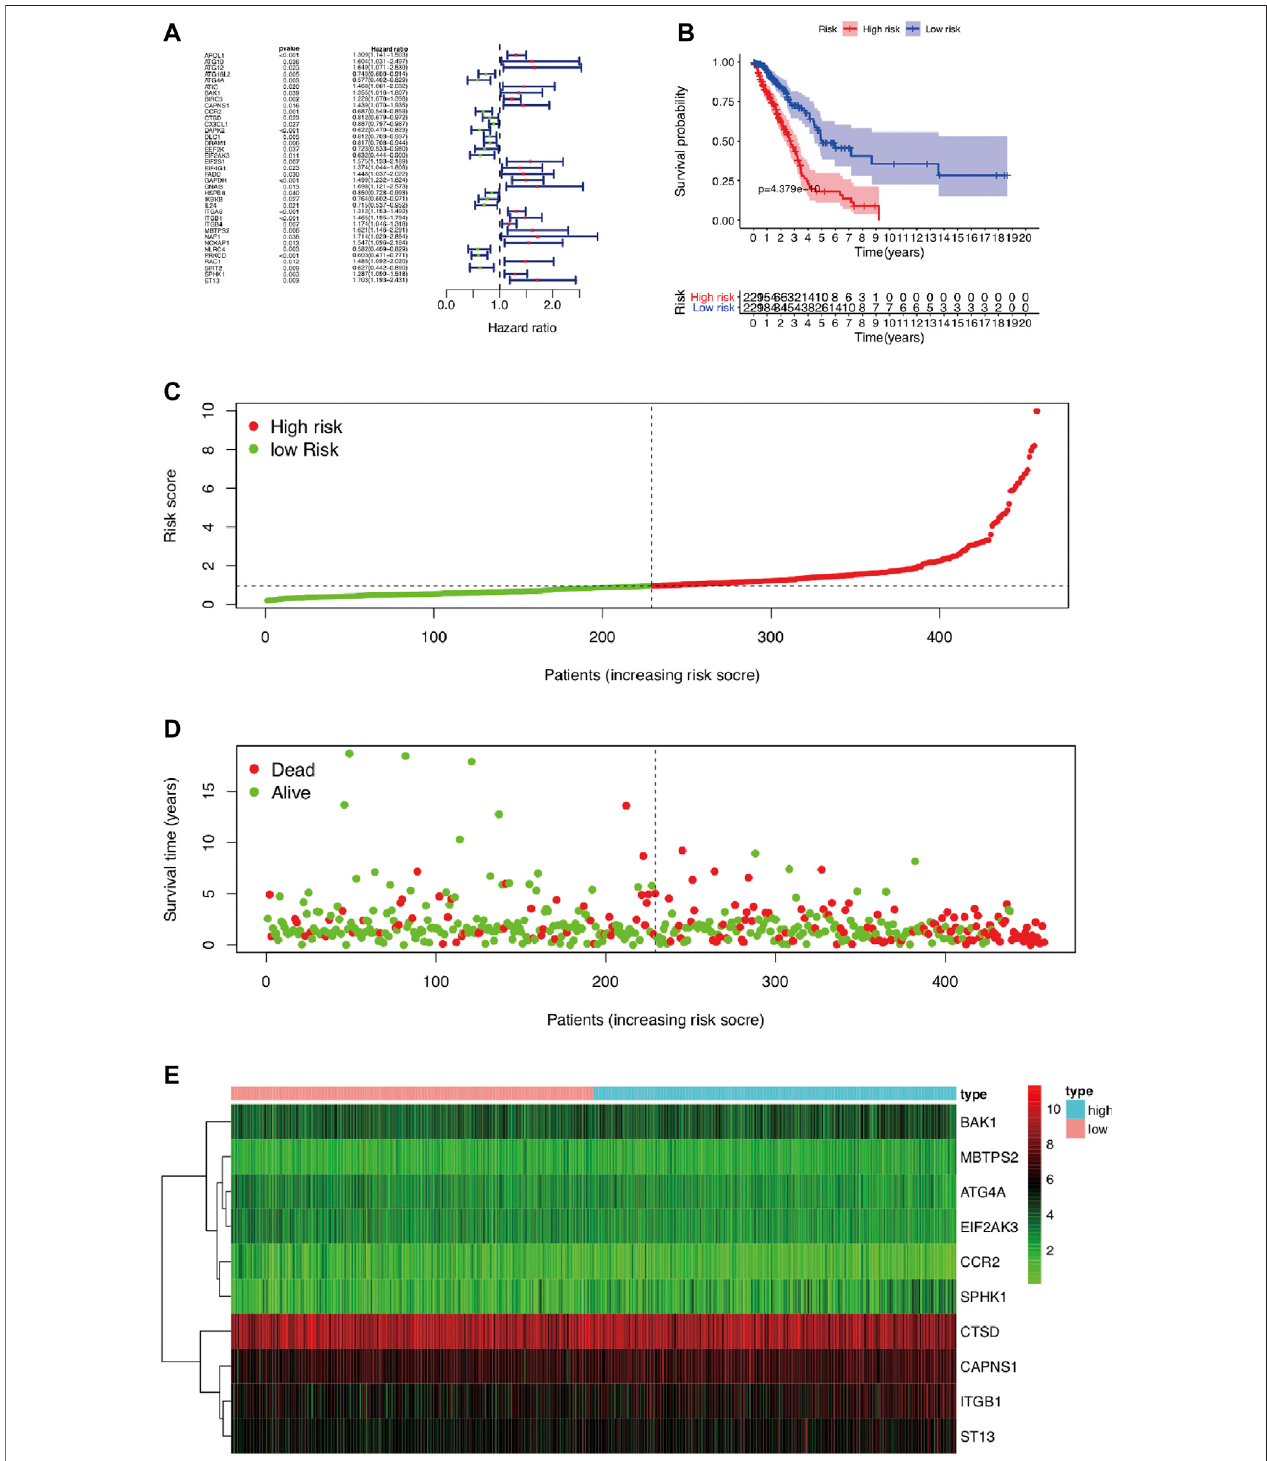
FIGURE 5 | The prognostic risk model based on ARGs in LUAD. (A) The univariate Cox regression analysis screened prognosis-related genes. (B) Kaplan – Meier analysisofOSbetweenhigh-risk and low-riskgroups inLUADpatientsbasedon riskscoresaccordingto12autophagy-related genesignatures. (C) Visualizationofthe risk score plot of high-risk and low-risk groups in LUAD patients. (D) Survival status was displayed in red and green dots based on the risk model as the risk score increasing in LUAD patients. (E) Two-dimensional hierarchical clustering of the signi fi cant 10 differentially expressed prognostic ARGs in high-risk and low-risk LUAD patients. ARGs, autophagy-related genes; LUAD, lung adenocarcinoma; OS, overall survival.